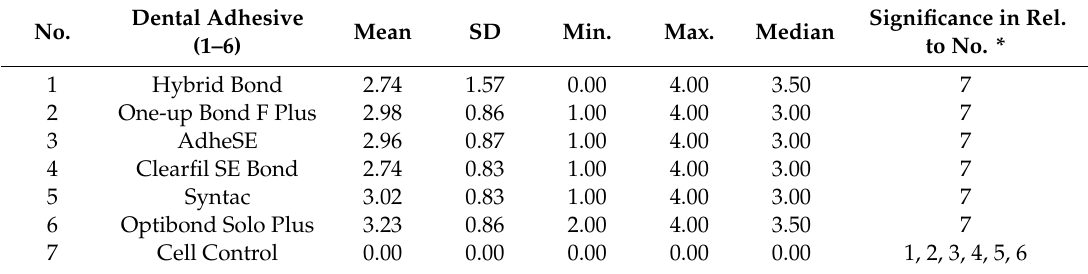
Table 10. Mean, standard deviation (sd), minimum (Min.), maximum (Max.) and median values of reactivity